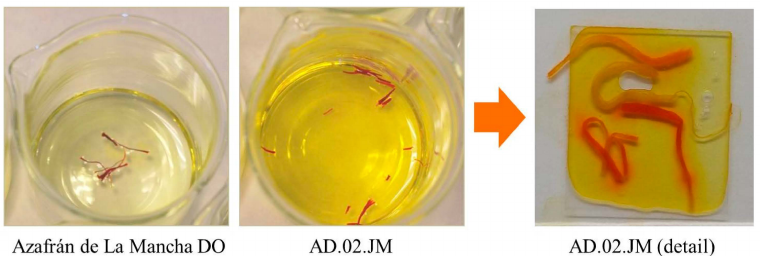
Figure 3. Comparison between same amounts of true saffron stigmas (Azafrán de La Mancha DO, Spain) and adulterated stigmas (Sample AD.02.JM) after just 3 min in cold water. It is clearly visible that, at the same time, adulterated saffron (dark yellow) releases color faster than true saffron (pale yellow). On the right, a detail of the adulterated stigmas from Sample AD.02.JM. There are clearly visible stigmas with different colors: red, pale orange, likely brown stigmas still decoloring and pale brown. The adulteration probably corresponds to the mixture and staining of two or more very old saffron stigmas with some fresh stigma lots.